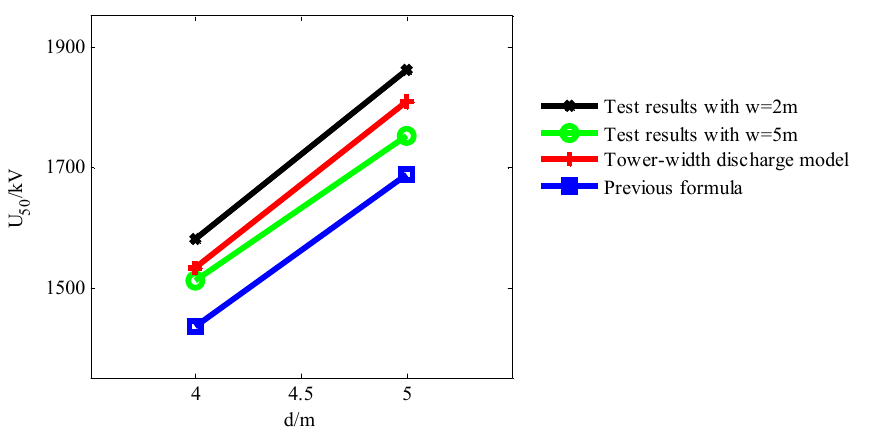
Figure 6. Comparison results between the tower-width discharge model, previous formulas, and tests.